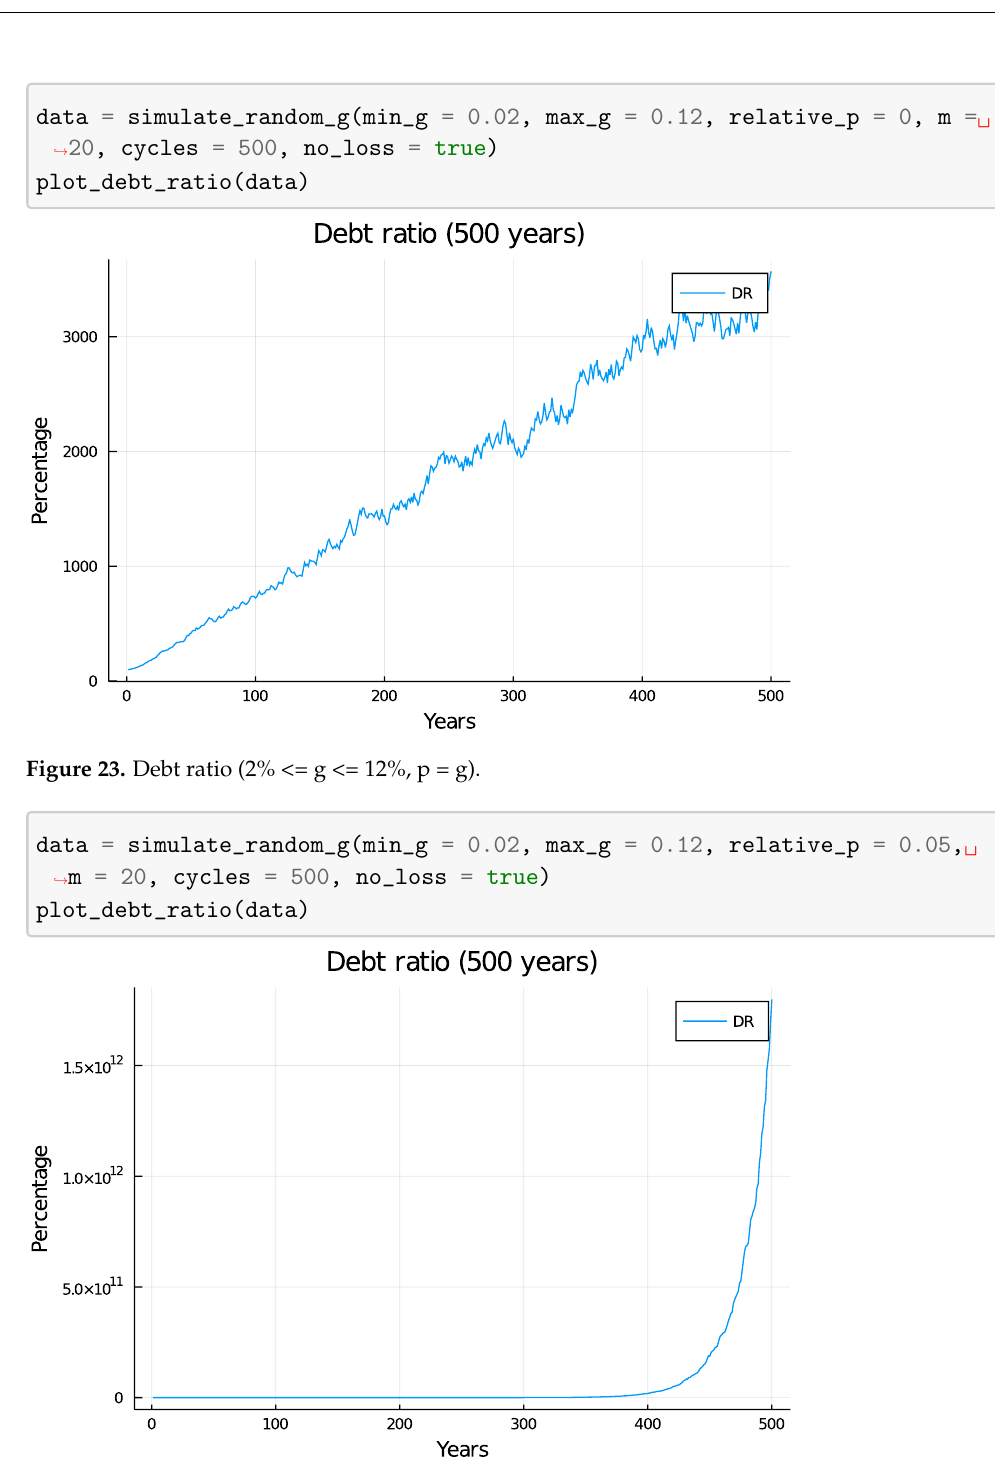
Figure 24. Debt ratio (2% <= g <= 12%, p = g +